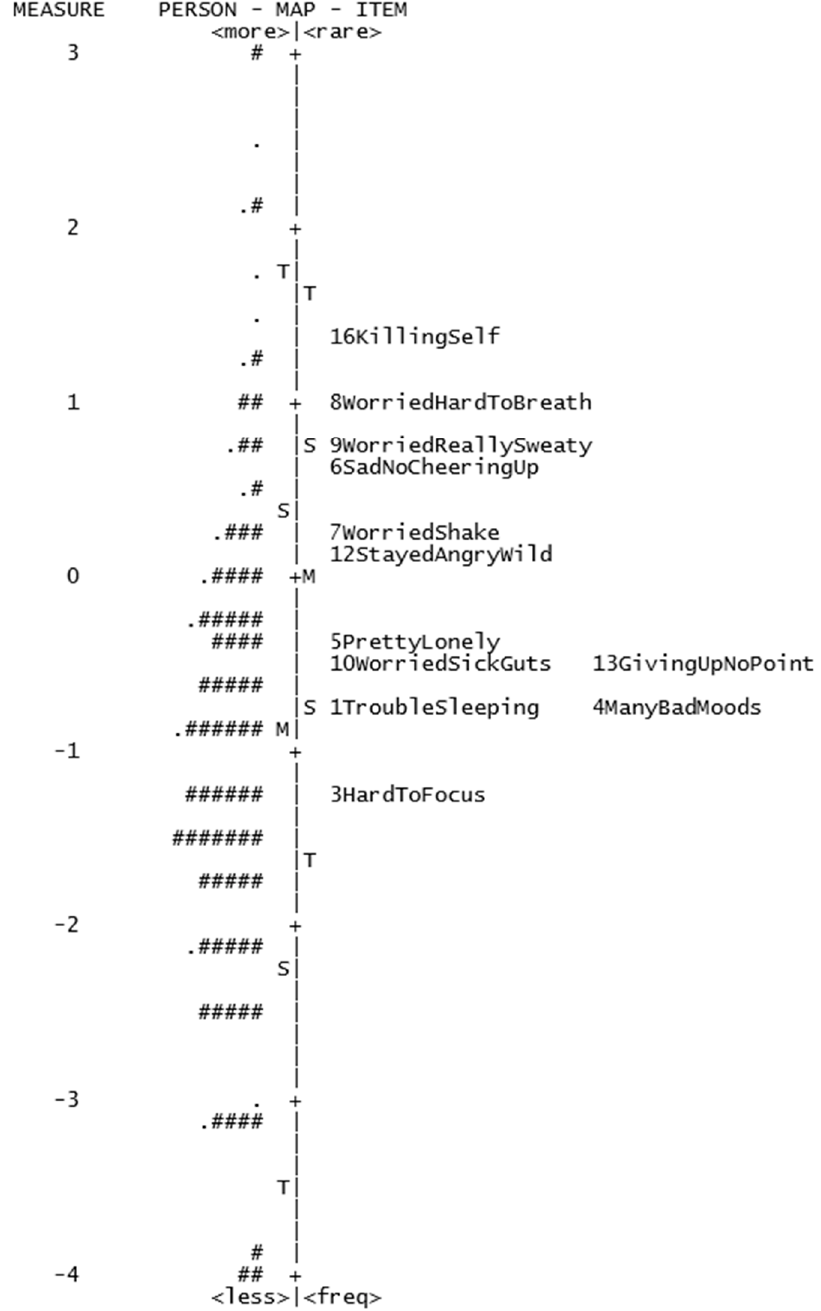
Figure 3. Person-item map of Distress subscale. Each ‘#’ represents 2 participants; each ‘.’ represents 1 participant. M = mean, S = 1 standard deviation ( SD ), T = 2 SD s. 1 participant. M = mean, S = 1 standard deviation ( SD ), T = 2 SD